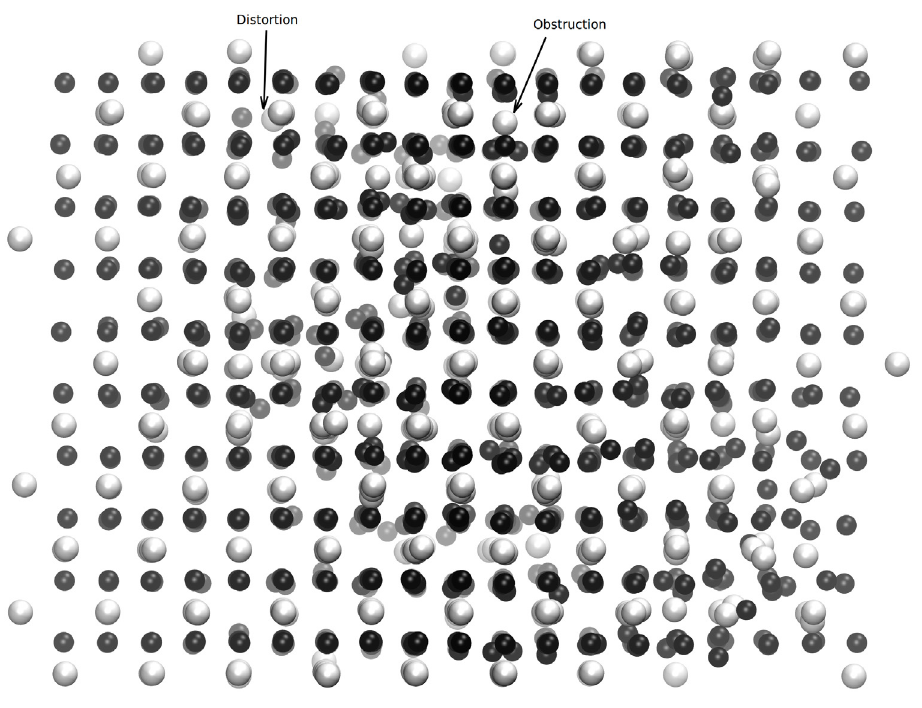
Fig 2. Equilibrium state from the < 110 > direction of a UO 2 supercell with 17 uranium IFPs seen. Distortion and obstruction type uranium (gray) defects are indicated with arrows. Distortion type defects are ions that have been slightly displaced into channels. Obstruction type defects are ions that occupy central positions within channels; they occupy special positions, have a constant coordination number, and can be considered to be ions trapped in cages. There is a relationship between the ingrowth of obstruction type defects and radiation-induced lattice